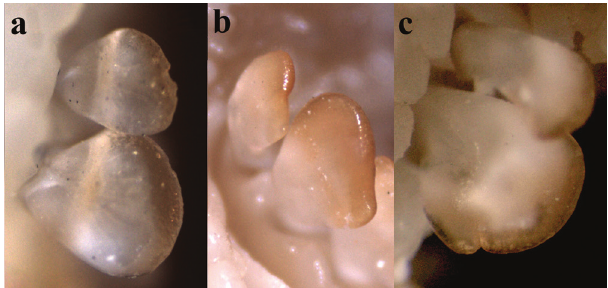
Fig. 6. Teeth of Panaqolus purusiensis : a) Teeth without lateral dent (UFRO-I 17720, premaxilla); b) teeth with rudiment of a lateral cusp in form of a small lateral dent (MUSM 39425, den- tary); c) tooth with small lateral cusp (MCP 45733, dentary).